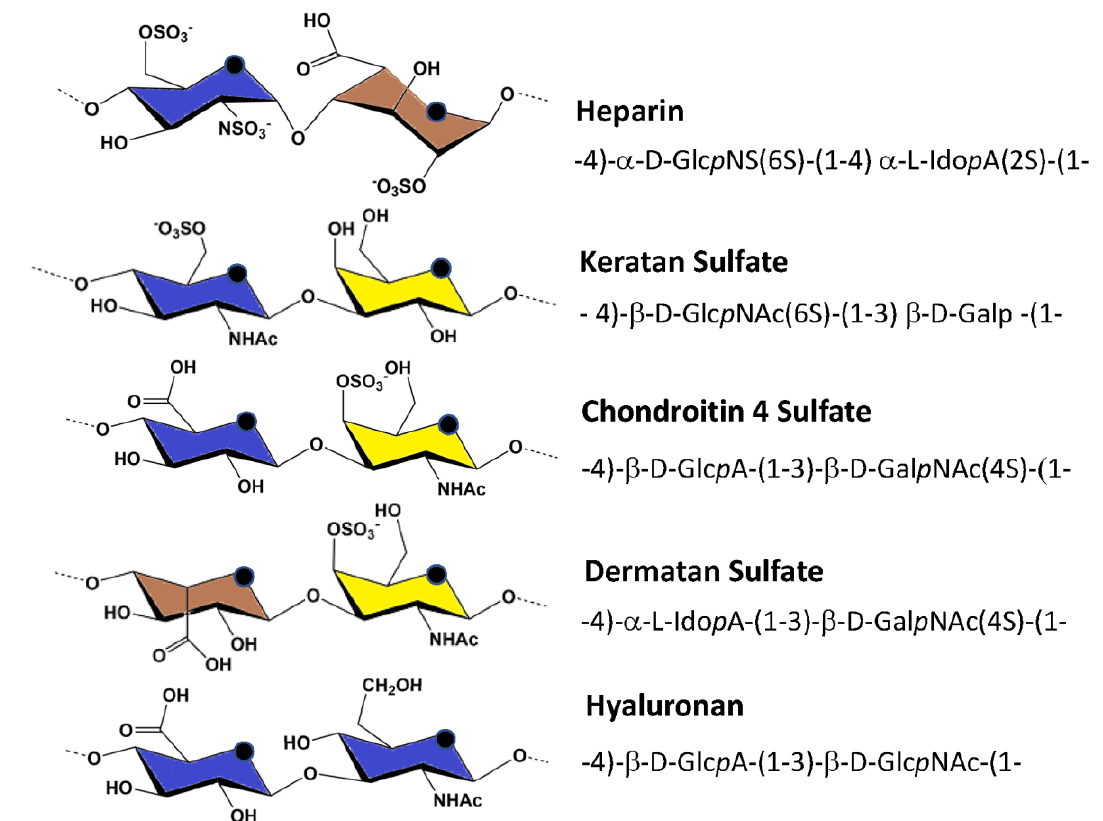
Figure 1. Main repeating units of glycosaminoglycans. The color-coding of the constituting monosaccharide complies with SNFG nomenclature [22]. The abbreviations are as follows: Glc p for glucose, Ido p for idose), Gal p for galactose, N for amine, S for sulfate, A for acid, and NAc for N- acetyl.